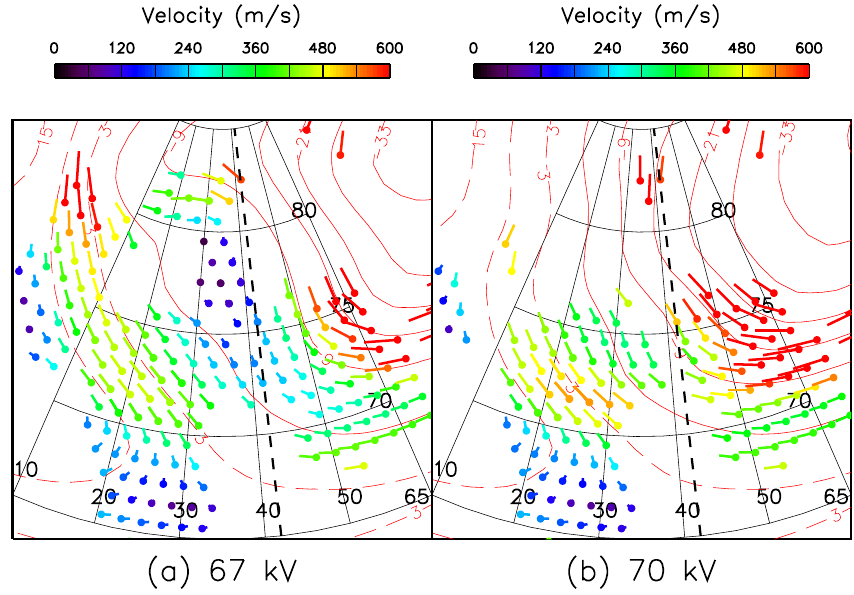
Fig. 9. Comparison of global convection map features in the noon sector in geomagnetic coordinates for the interval 14:00–14:02 UT on 11 February 1998, representing (a) default processing, and (b) velocity-range gate filtering. The arrows represent the flow determined from the global convection mapping solution at grid points where data were entered. The solid (dashed), red lines represent equipotentials of the estimated convection electric field for the afternoon (morning) convection cell. The bold, dashed line represents the location of magnetic local